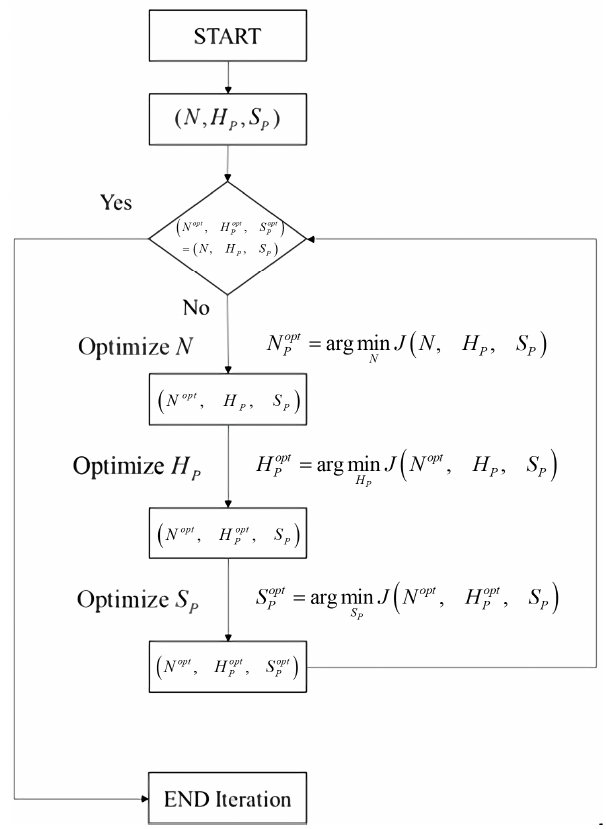
Figure 3. The procedures of iterative parameter tuning.